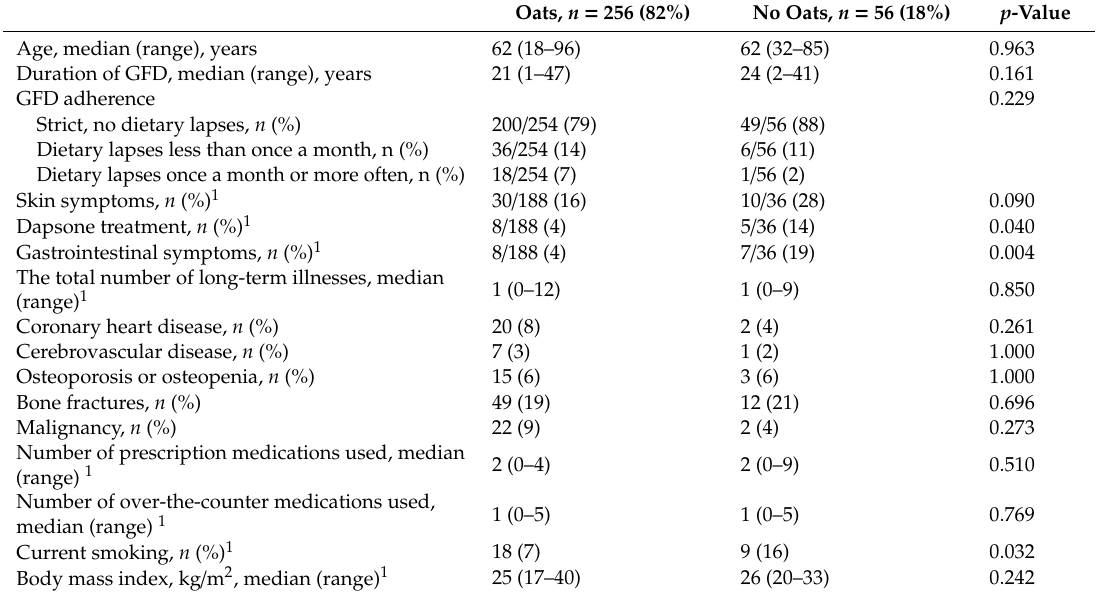
Table 2. Long-term follow-up data of 312 dermatitis herpetiformis (DH) patients on a gluten-free diet (GFD) with or without of